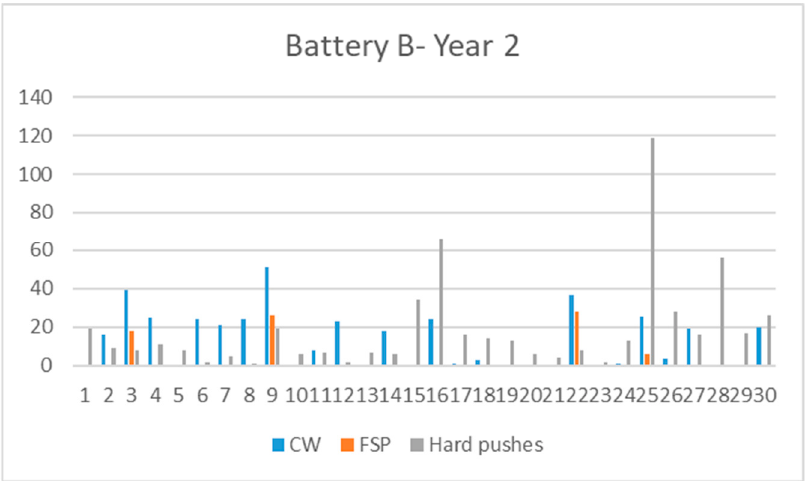
Figure 11. Hard pushes and refractory repairs battery B, year 2.